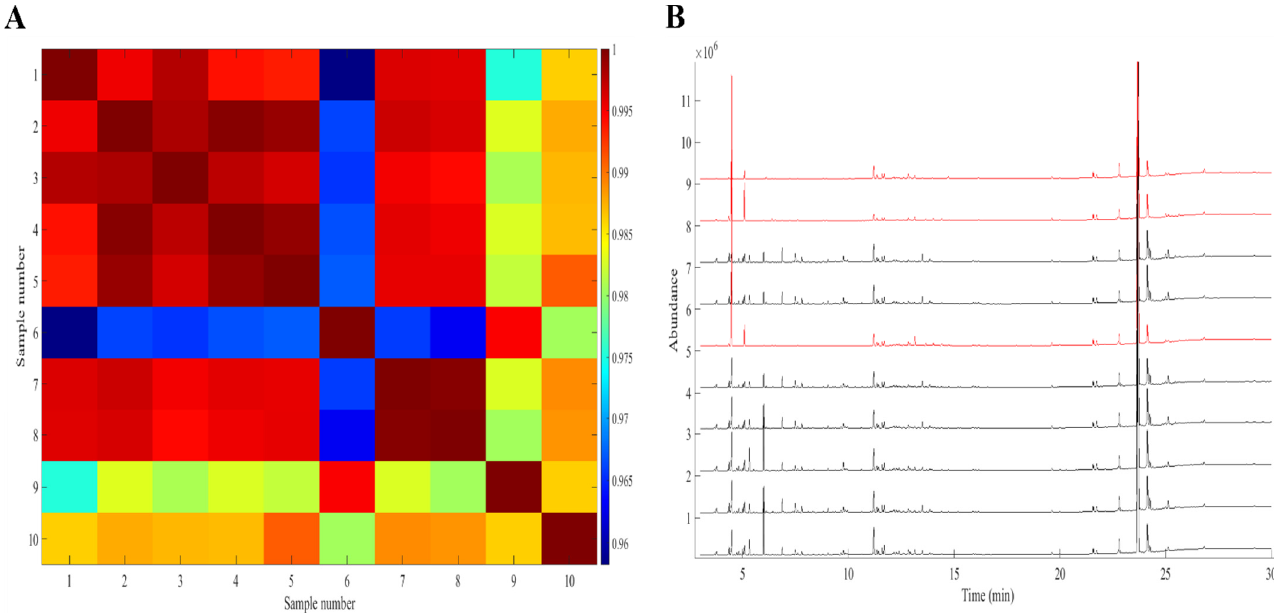
Figure 1. Cannabis fingerprints derived from ( A ) GC–FID and ( B ) GC–MS (without THC peak).